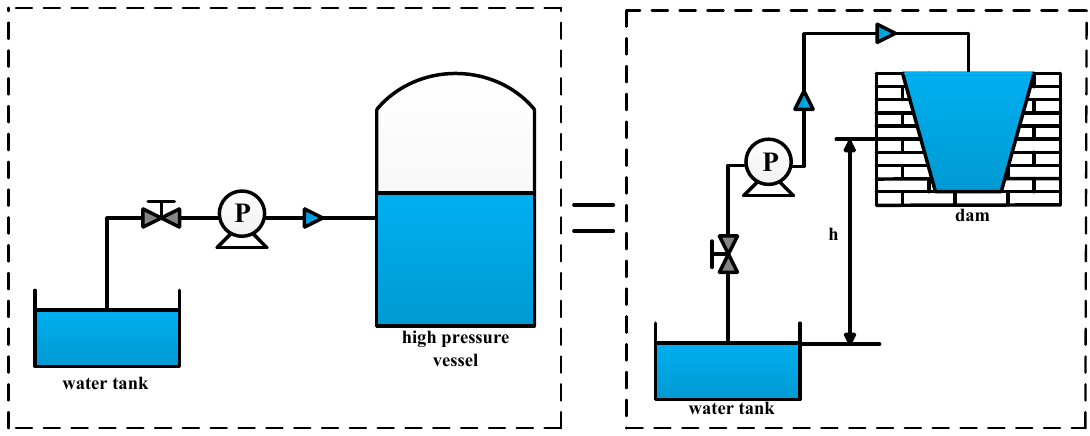
Figure 1. The physical model of pumped hydro combined with compressed air energy storage system